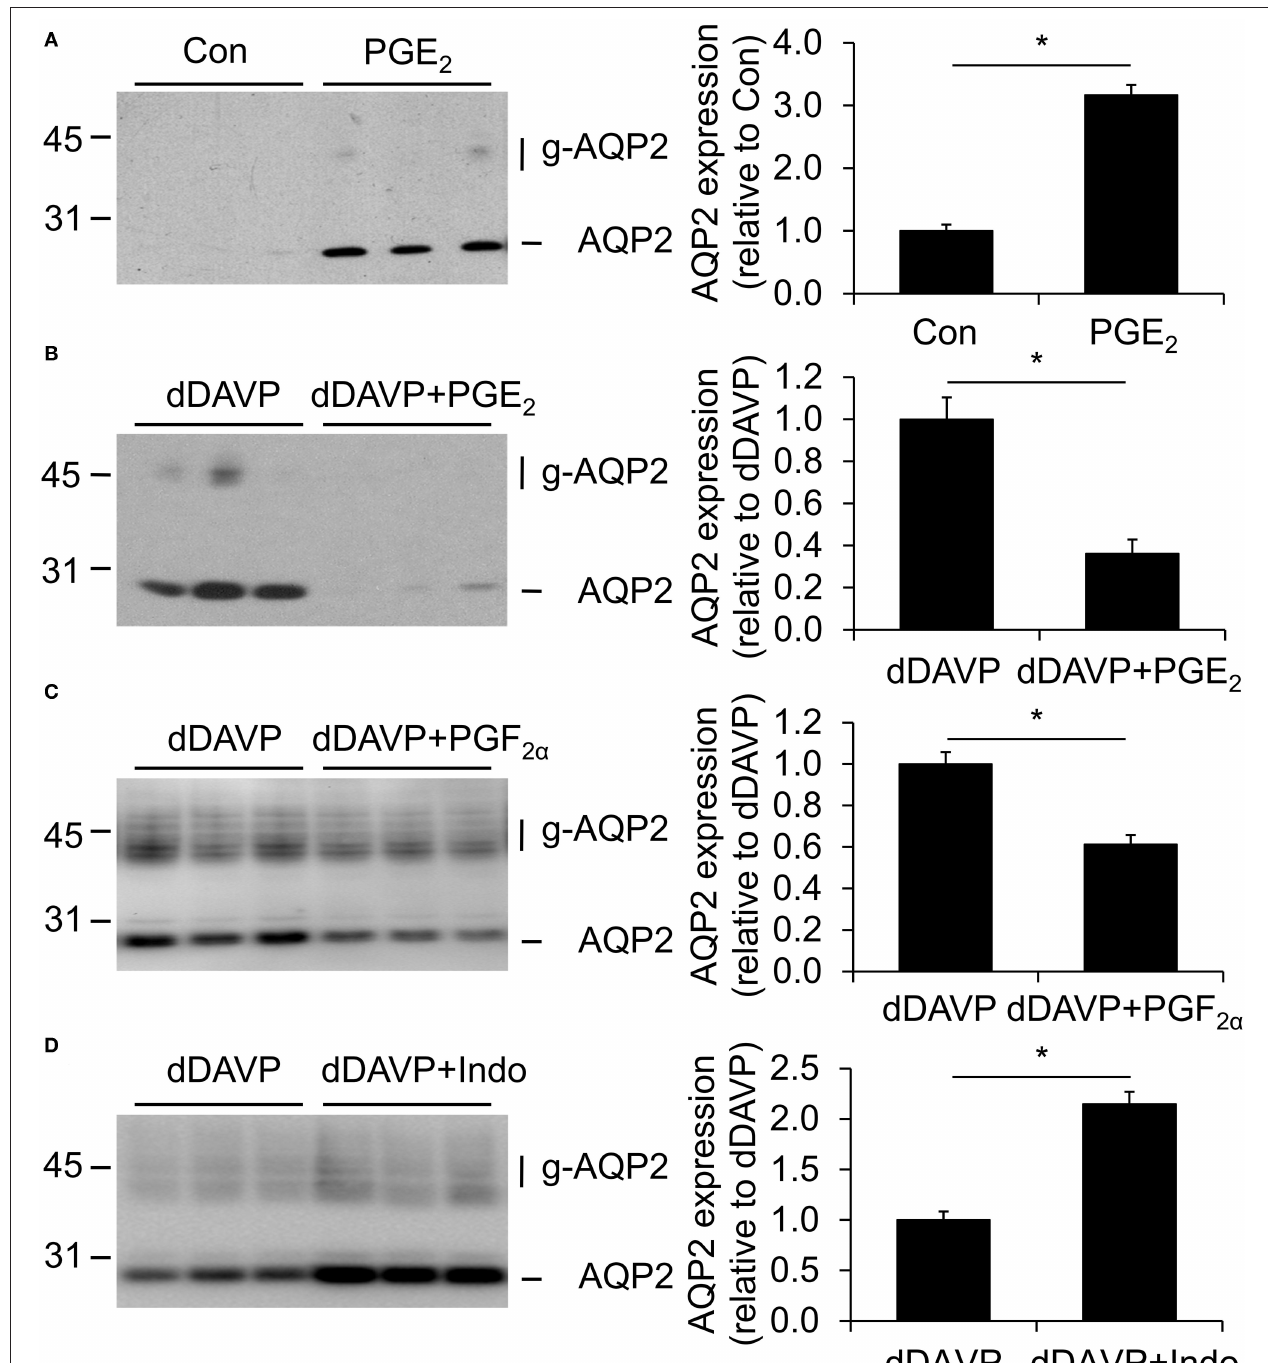
FIGURE 2 | Effect of prostaglandins on aquaporin-2 (AQP2) expression. MpkCCD c14 cells were grown for 8 days, either with or without 1nM desmopressin (dDAVP) stimulation for the last 4 days and with or without 1 µ M PGE 2 (A,B) , 1 µ M PGF 2 α (C) , or 10 µ M indomethacin (D) during the last 48h. Cells were lysed and subjected to immunoblotting for AQP2. Molecular masses (in kDa) are indicated on the left. Nonglycosylated (AQP2) and complex-glycosylated (g-AQP2) forms of AQP2 are detected and densitometrically quantified. Significant differences from control or dDAVP alone ( p < 0.05) are indicated by an asterisk. Bars are mean values of nine filters per condition ( ±